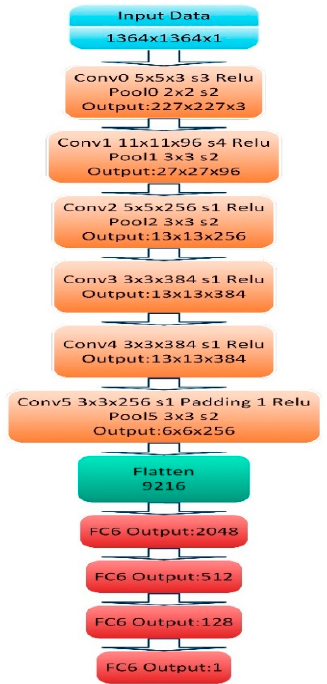
Figure 2. Complete network structure of the chemical mechanical polishing (CMP) surface height model with convolutional neural network (CNN).